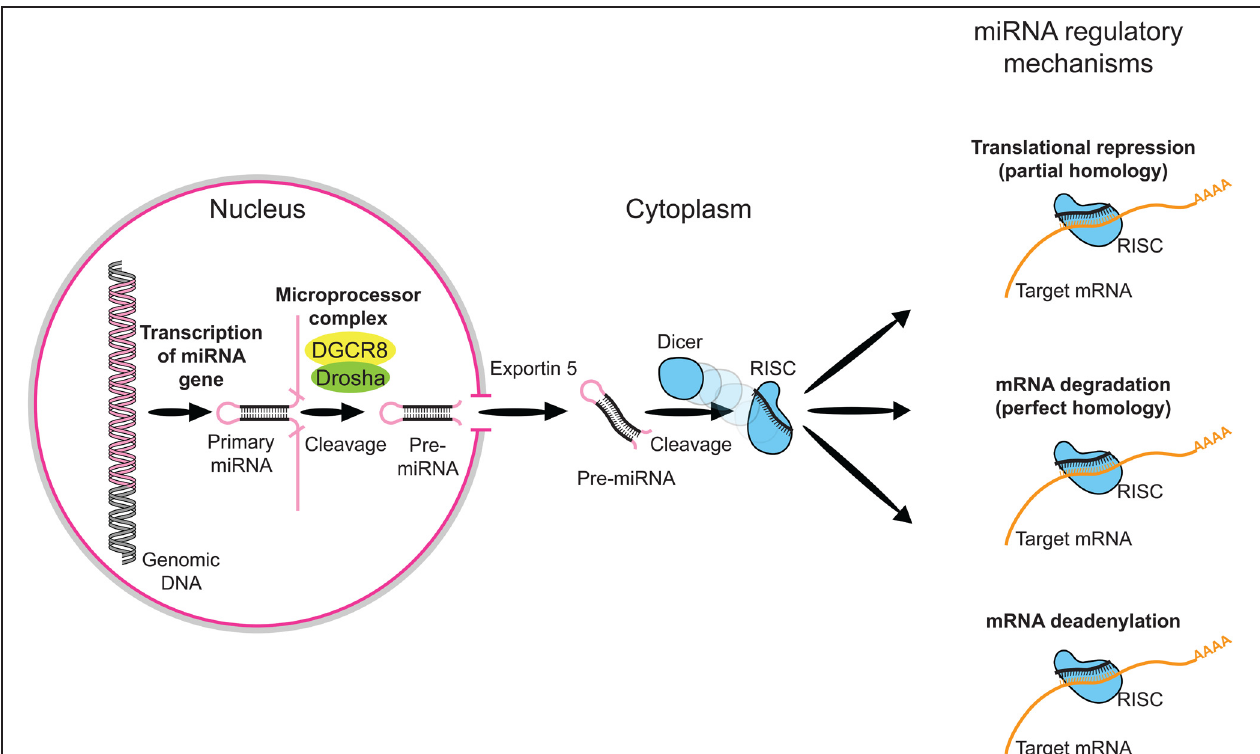
which yields long primary miRNA (pri-miRNA) transcripts. The pri-miRNA is processed in the nucleus to a pre-miRNA by the Microprocesser complex, which consists of Drosha, a member of ribonuclease III family (RNaseIII), and DGCR8 (also known as Pasha), which contains two double-stranded RNA binding domains and is responsible for pri-miRNA recognition. The pre-miRNA is then exported to the cytoplasm by Exportin-5 and further processed into a miRNA duplex by Dicer, another RNase III. One strand of the miRNA duplex is then incorporated into the